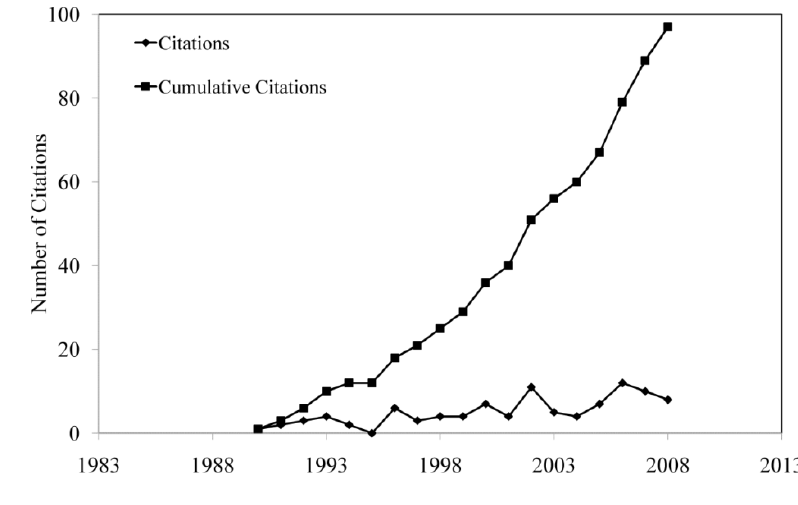
Figure 1. “Citations of the reverse salient concept in the literature at